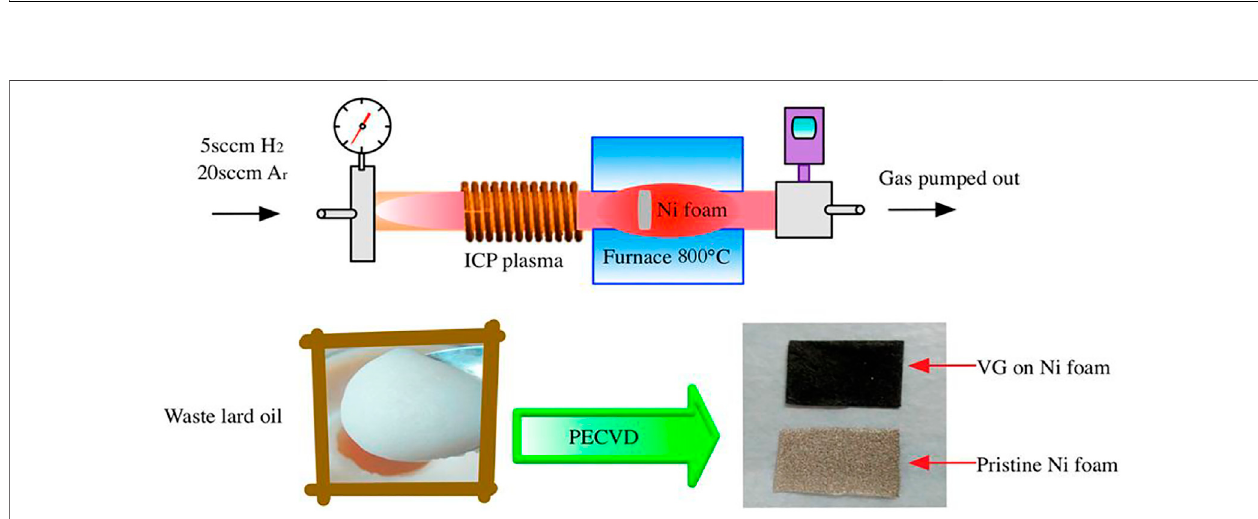
FIGURE10| Schematicdiagramofinductivelycoupledplasma-enhancedchemicalvapordeposition(ICP-PECVD)appliedforthesynthesisofwastelardoil-based vertical graphene (Wu et al., 2017).